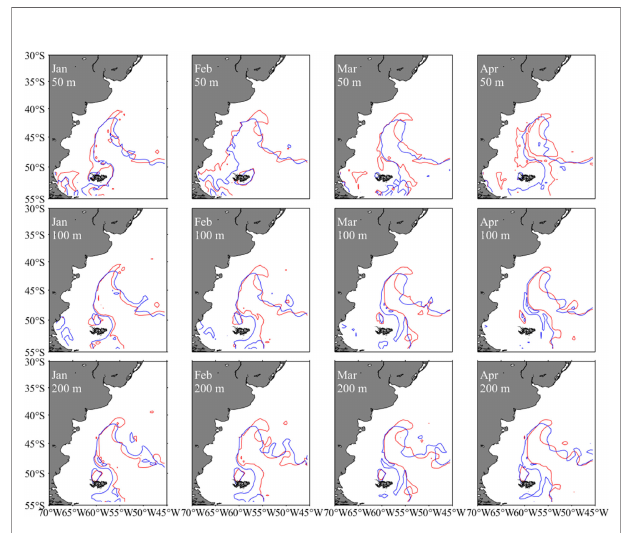
FIGURE 11 | Spatial distribution of optimum temperature isotherms for Illex argentinus at different depths in 2014 and 2017 from January to April (the red line indicated the isotherm in 2014 and the blue line indicated the isotherm in